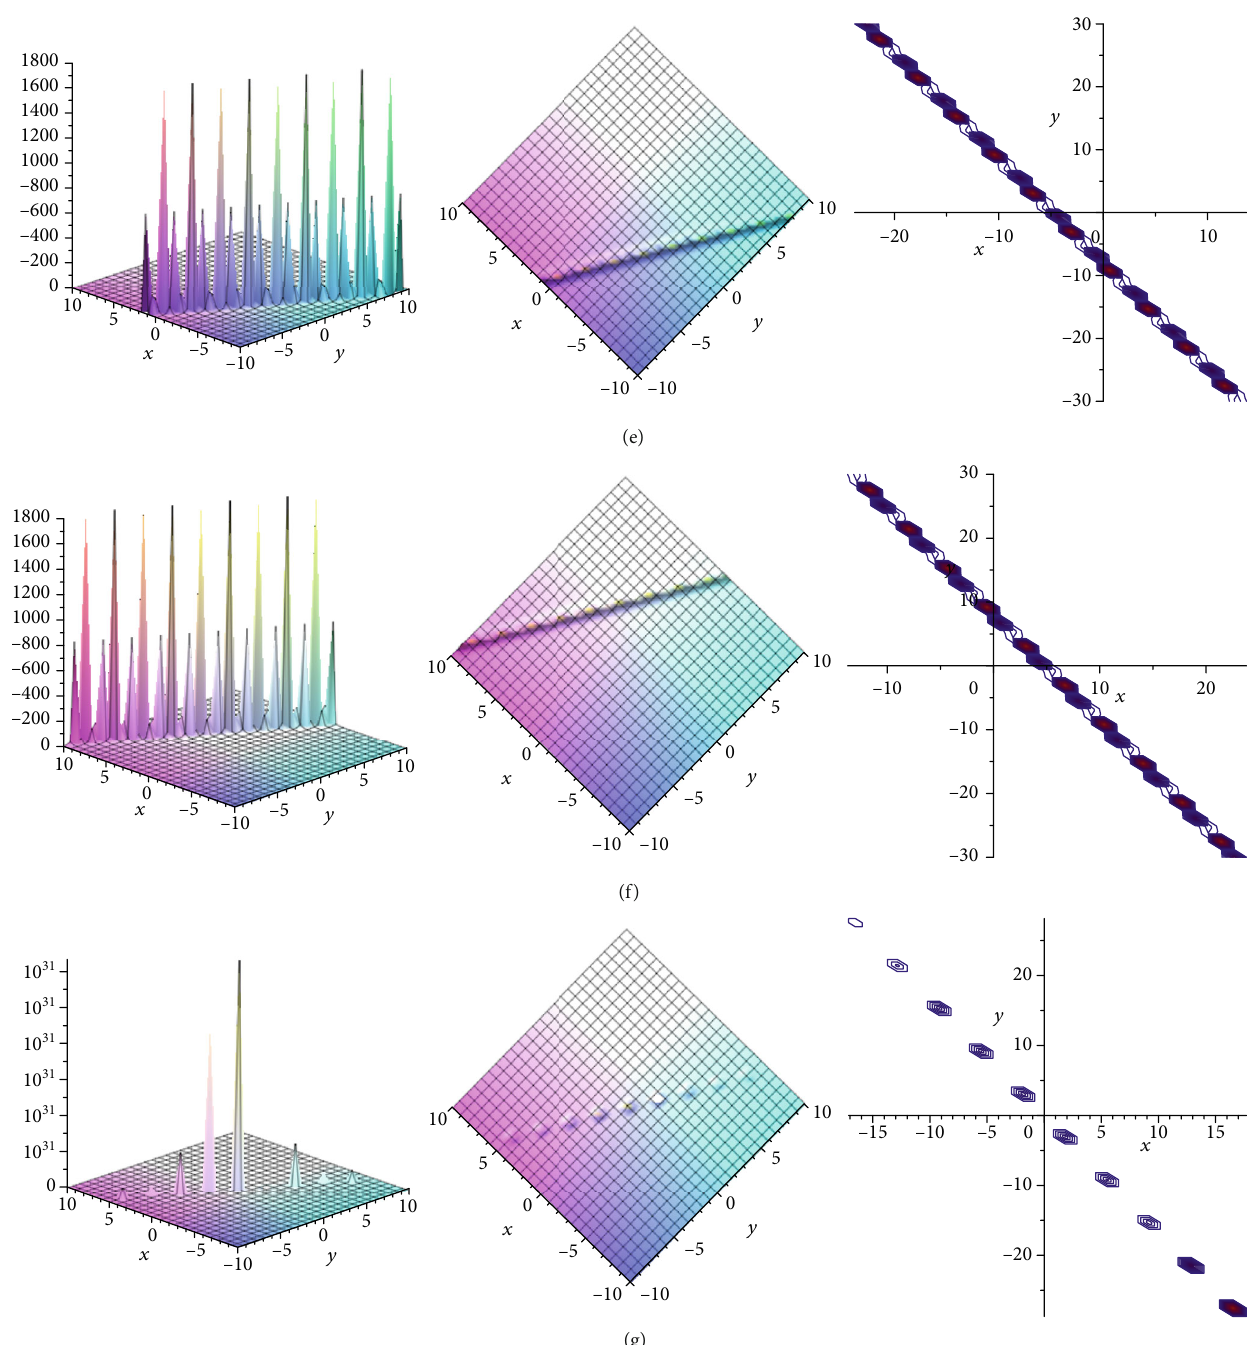
Figure 1: 3D plots and contour plots of equation (21) by choosing a = 7, b = 5, C